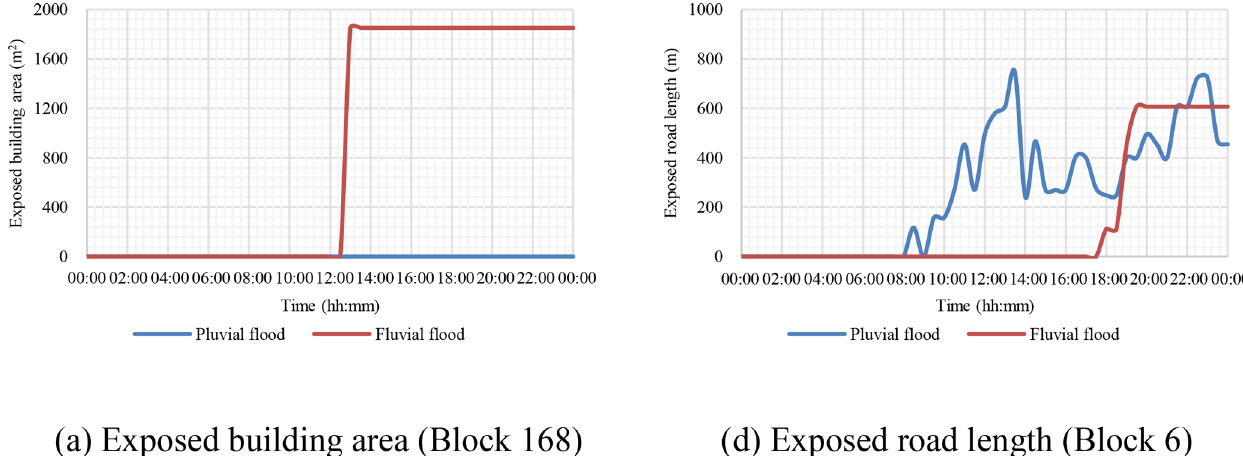
Figure 15. Changes in road and building exposures in severely flooded blocks. The exposed road length and building area represent road and building exposures,